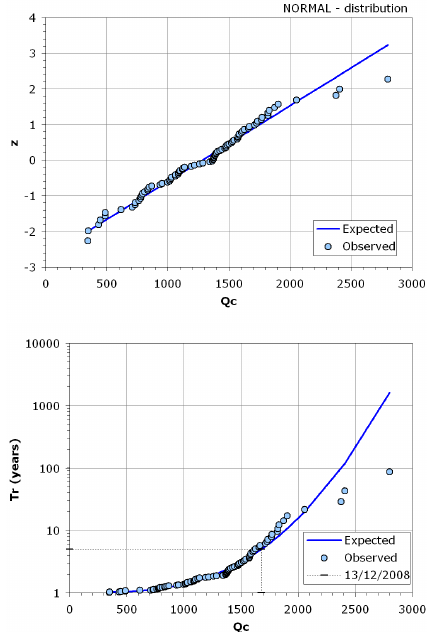
a 3-h basis) have been considered for the comparison. Be-